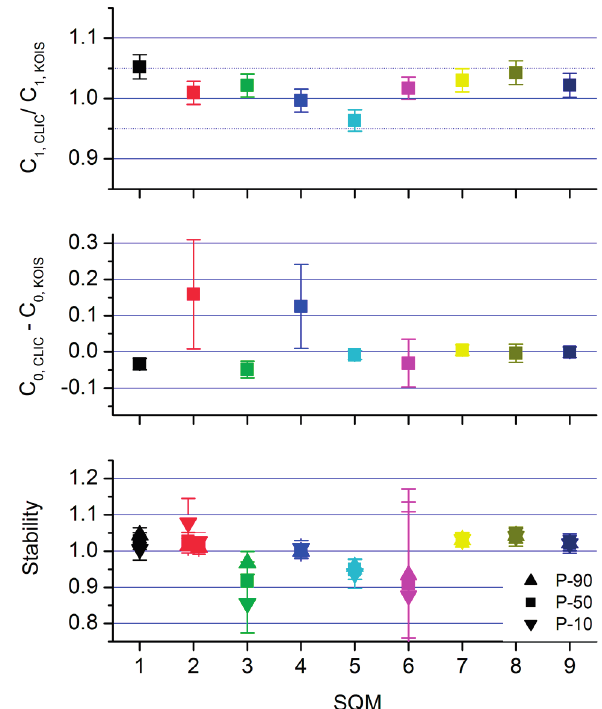
Figure 6. Year-to-year stability of the monitoring SQMs. Top : slopes. Middle : offsets, the unit is mcd/m 2 . Bottom : combined impact of slope-change and offset-drift on the 10-percentiles, median and 90-percentiles of the observed luminance at the monitoring